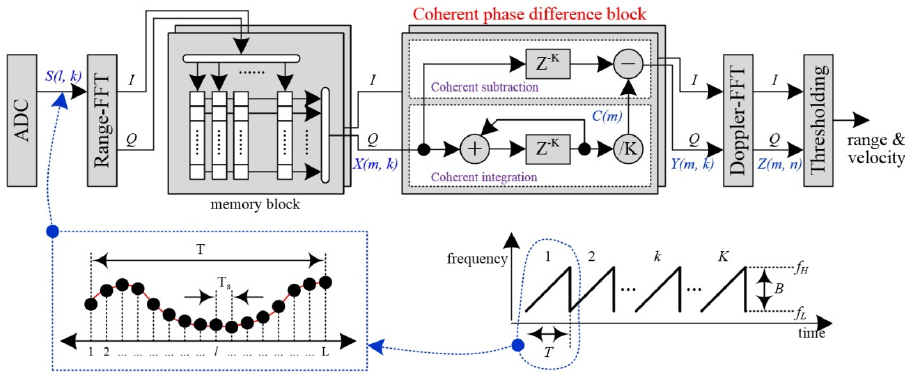
Figure 2. The proposed pedestrian detection scheme using coherent phase difference for 2D range-Doppler FMCW radar.